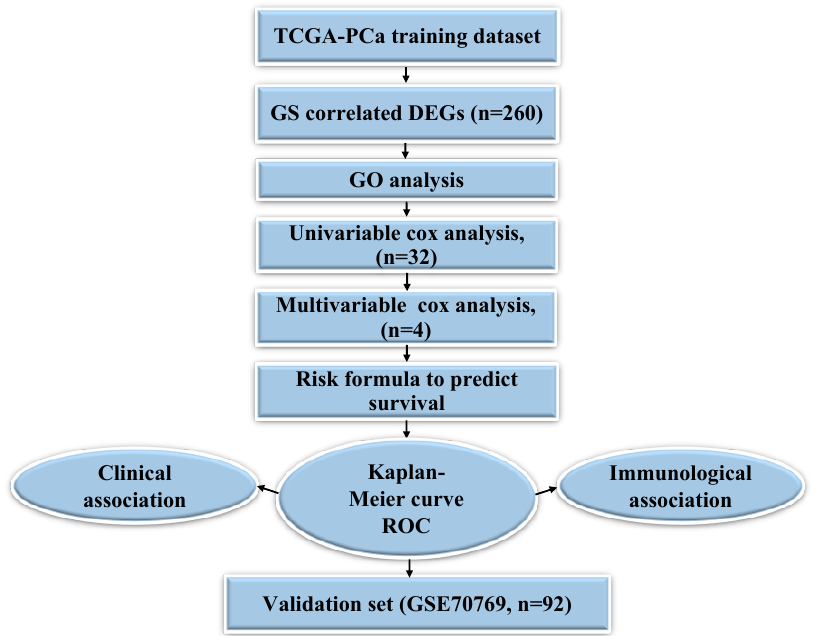
Figure 1. Flow chart of methods for building the Gleason Score (GS) based four-gene signature for prediction of BCR free survival in prostate cancer (PCa) patients; DEGs: differentially expressed genes